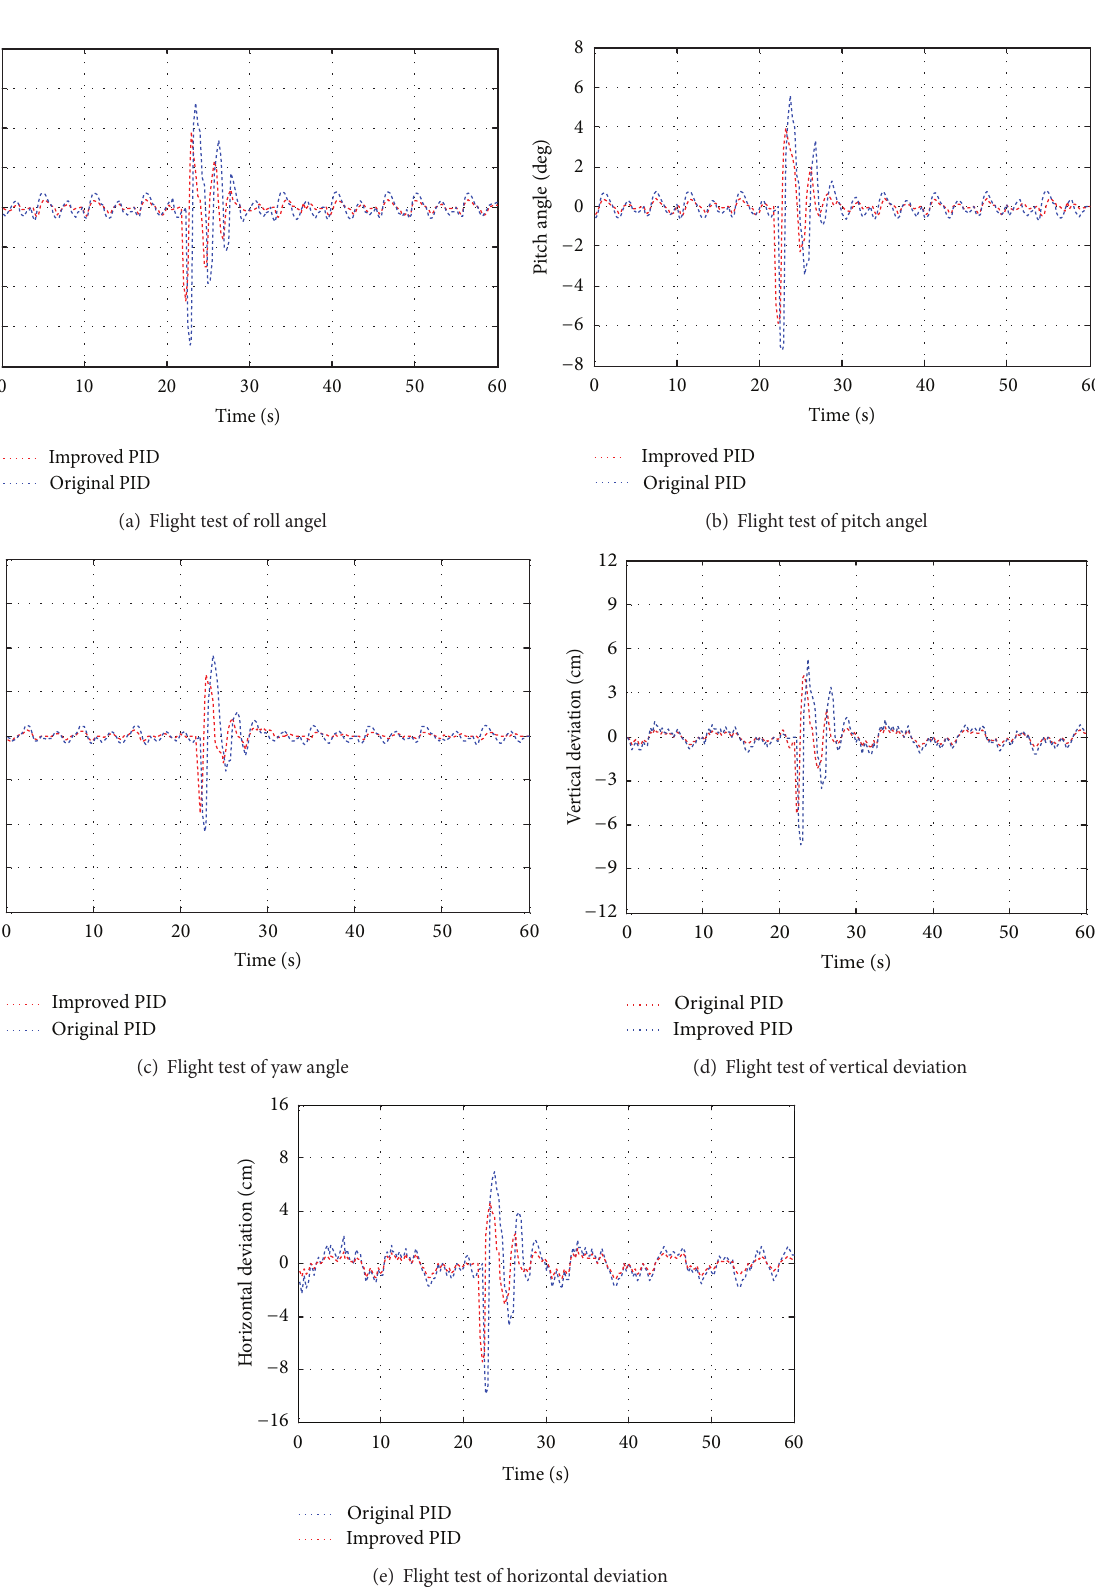
Figure 10: Performance comparison about flight angle and flight